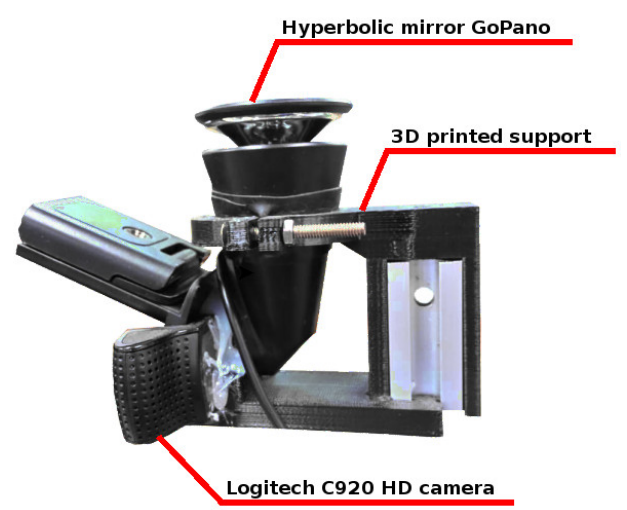
Figure 2. Part of the proposed sensor for capturing 360 ◦ RGB